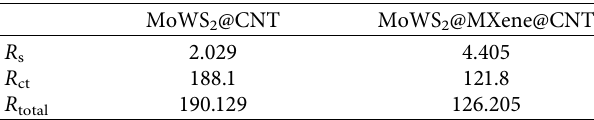
Figure 9: (a) EIS of MoWS2@MXene@CNT/S and MoWS2@CNT/S (a) after and (b) before the multiplication cycle. Table 1: Composite impedance ftting values (in Ω ).